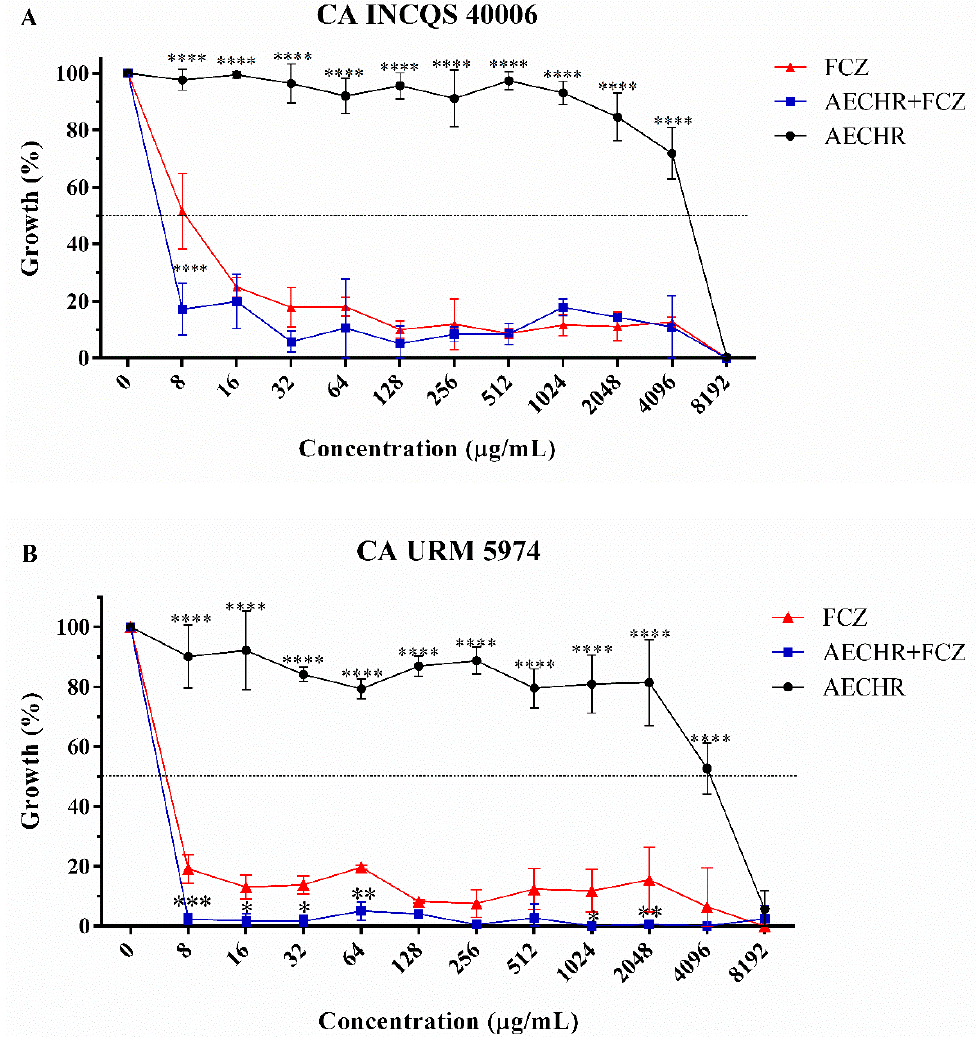
Figure 4. Cell viability curve of Candida albicans strains (( A ), CA INCQS 40006; ( B ), CA URM 5974) treated with the aqueous extract of C. heliotropiifolius roots (AECHR) or fluconazole (FCZ). ( A )—**** = p < 0.0001; ( B )—* = p < 0.05; ** = p < 0.01; *** = p < 0.001.